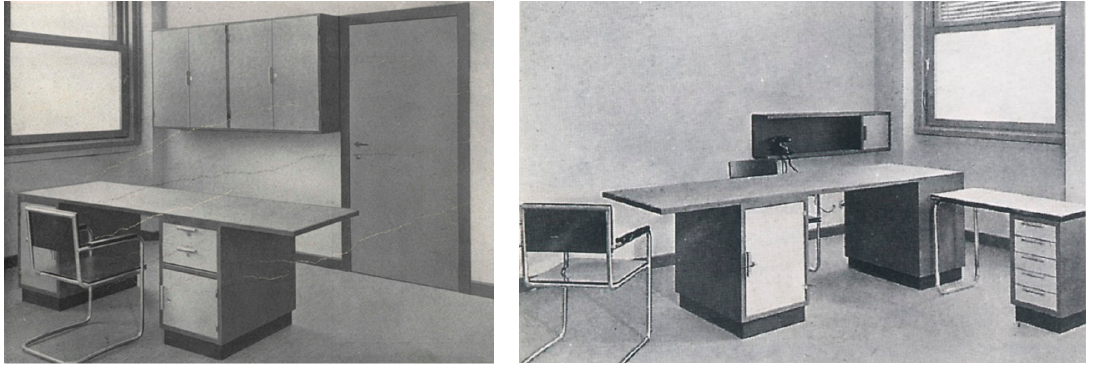
Figure 42. Institute of Physics. Type office. Photo from (De Smaele 1936, p. 24).